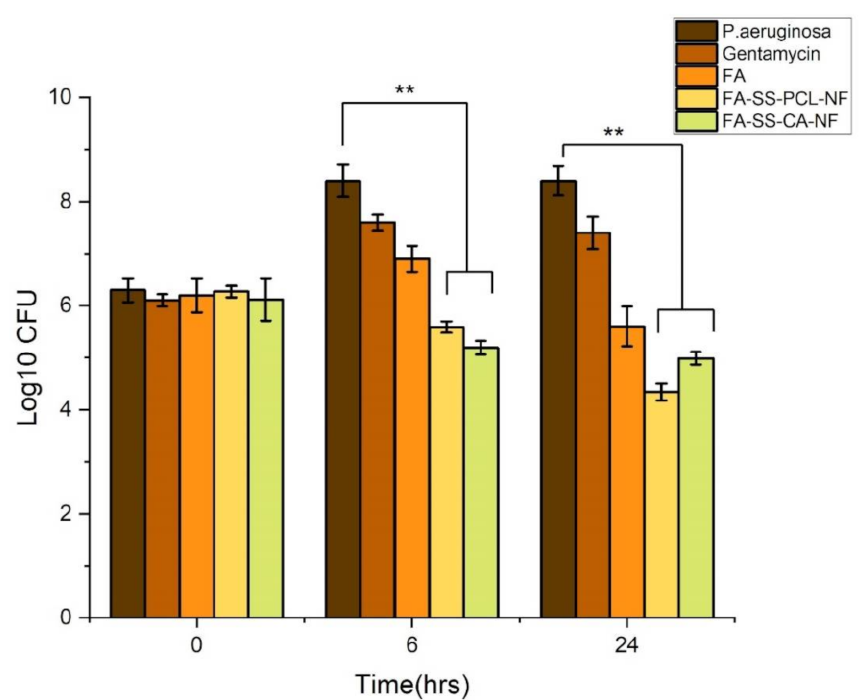
Figure 7. Bar graph of time-kill assay results against Pseudomonas aeruginosa. The error bars indicate the mean ± S.D. ** Significant differences between control, drug, and the formulations corresponding to